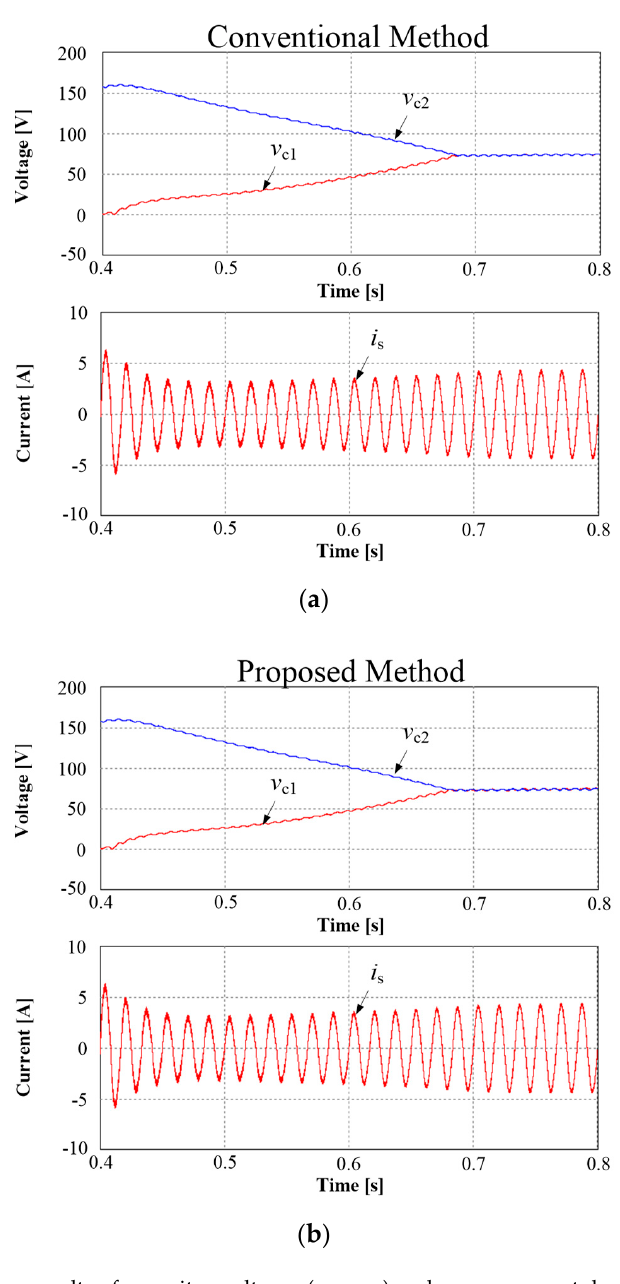
Figure 10. Simulation results of capacitor voltages ( v c1 , v c2 ) and source current during imbalanced NP voltage conditions obtained by ( a ) conventional method and ( b ) proposed method.